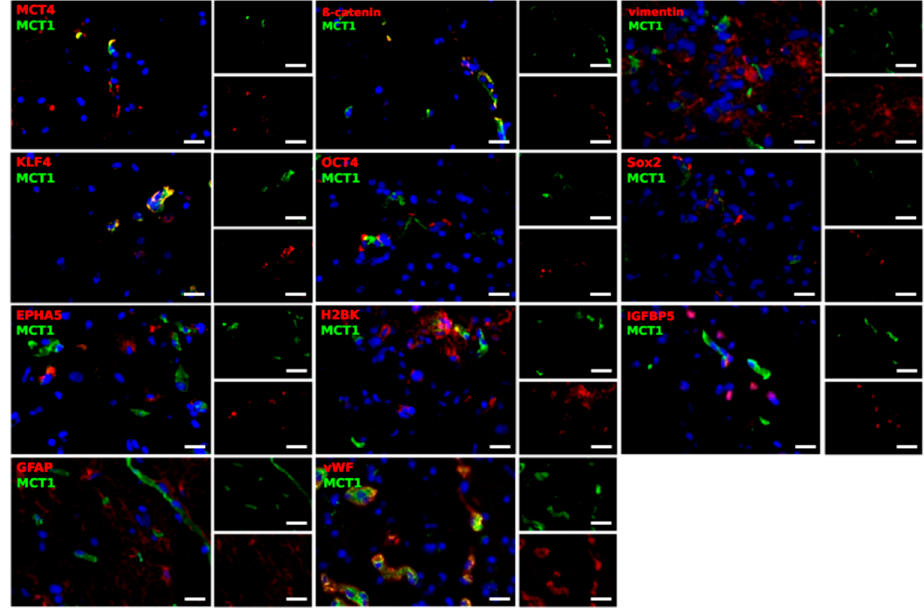
Figure 5. Representative co-staining of MCT1 with EMT markers ( β -catenin, vimentin), stem-like cell markers (KLF4, OCT4, Sox2), dormancy markers (EPHA5, H2BK, IGFBP5) and GFAP, as well as vWF in pairs of center and edge glioblastoma samples as determined by immunofluorescence microscopy. MCT1 and MCT4 (green) are found in different combinations with cell-specific markers (red) in a complex pattern. Magnification 400×; bar = 20 μ m.